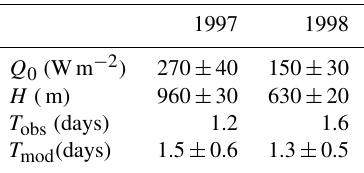
Table C1. Surface heat flux Q 0 , ML depth H , and observed over- turning time T obs as reported in (Steffen and D’Asaro, 2002).